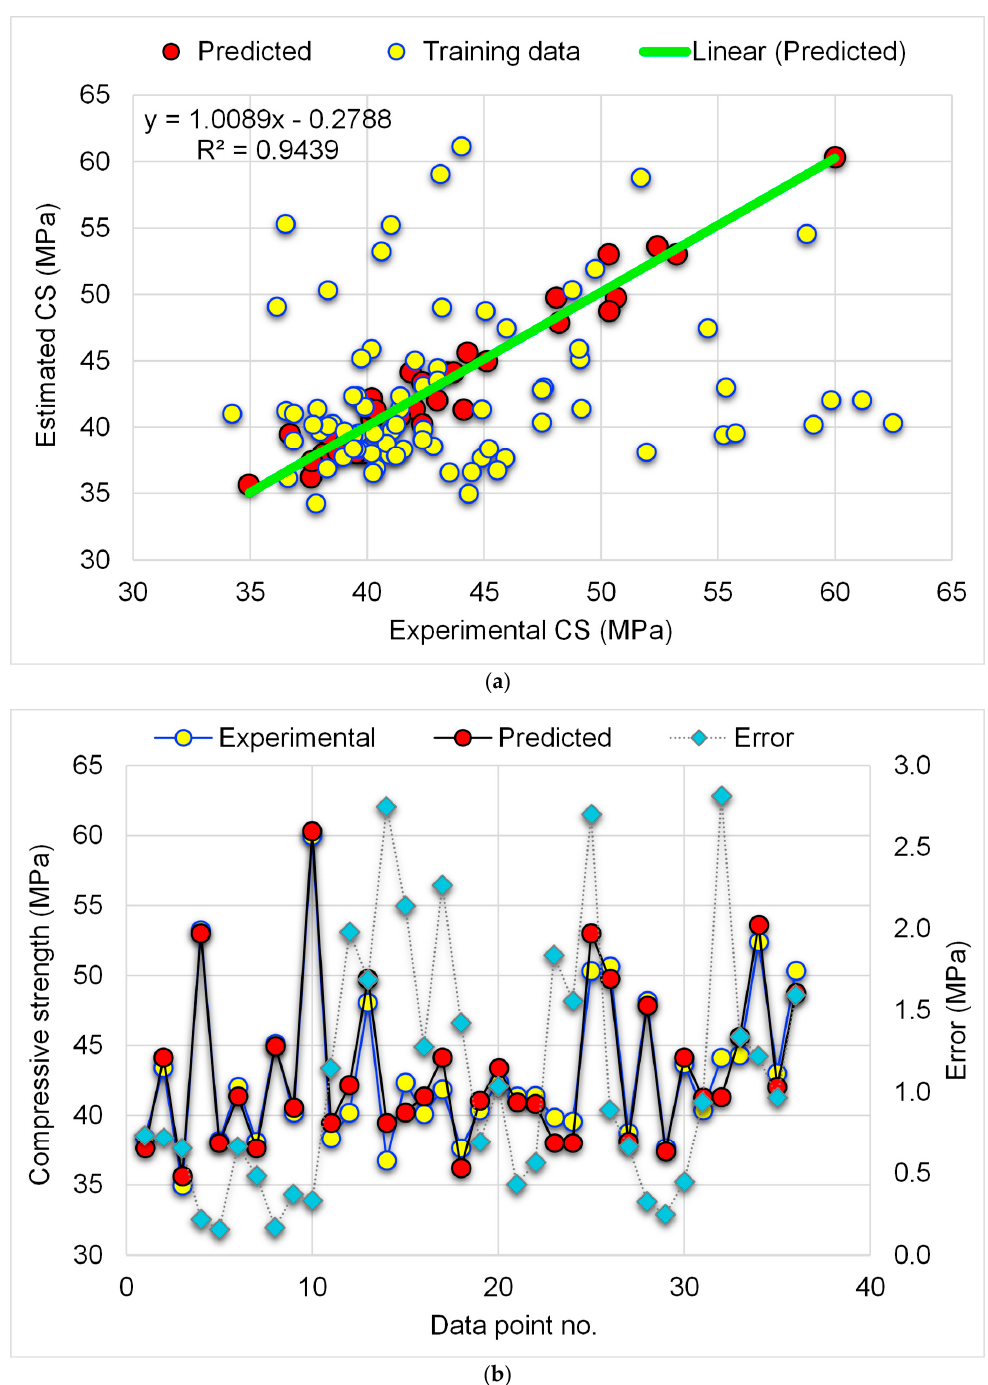
Figure 8. RFR-CS model: ( a ) correlation amongst experimental and predicted CS; ( b ) distribution of experimental and predicted CS and error values.